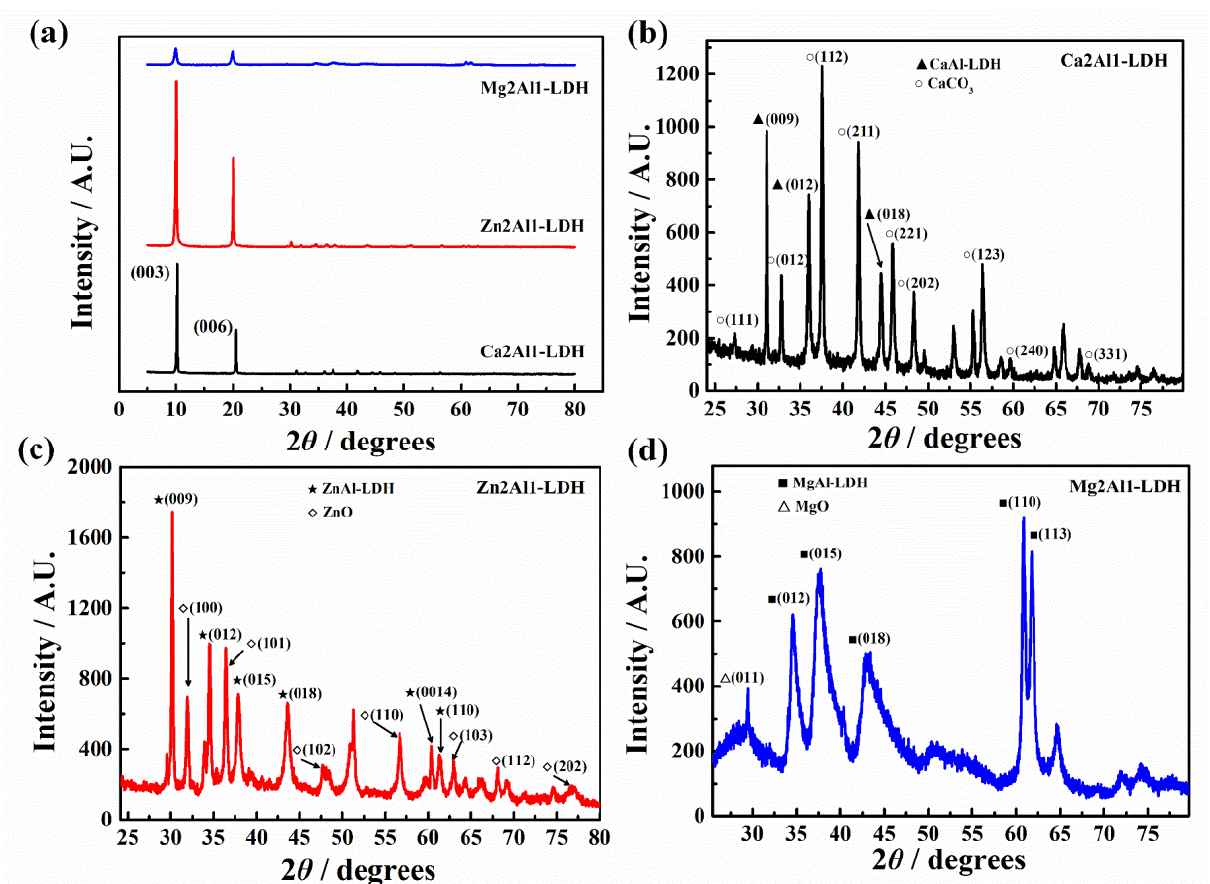
Figure 4. The XRD results of ( a ) Ca2Al1-LDH, Zn2Al1-LDH and Mg2Al1-LDH from 5 to 80°; ( b ) Ca2Al1-LDH from 24 to 80°; ( c ) Zn2Al1-LDH from 24 to 80° ( d ) Mg2Al1-LDH from 24 to 80°. The XRD spectrum of ZnAl-LDH samples with different divalent cation to